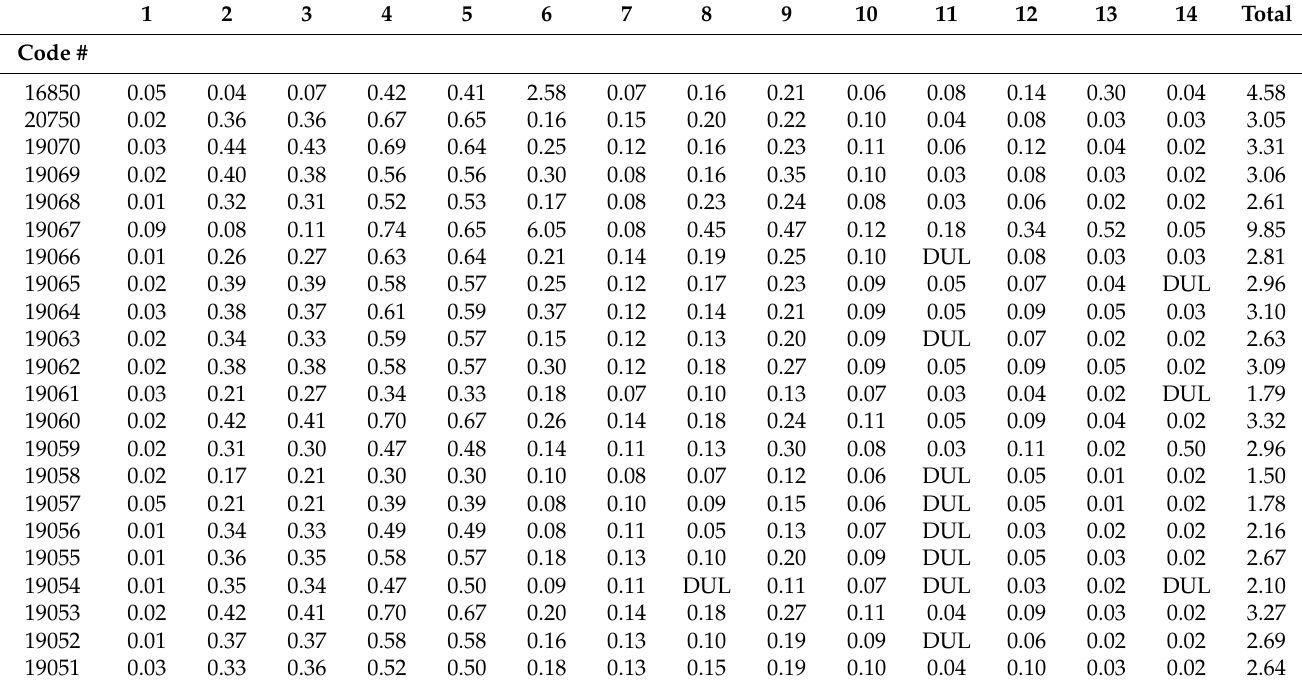
Table 3. Distribution and content of 14 phytochemicals (%, mg/100 mg sample weight) in authenti- cated green plant material (16850) and 21 herbal supplements claimed to contain A. linearis